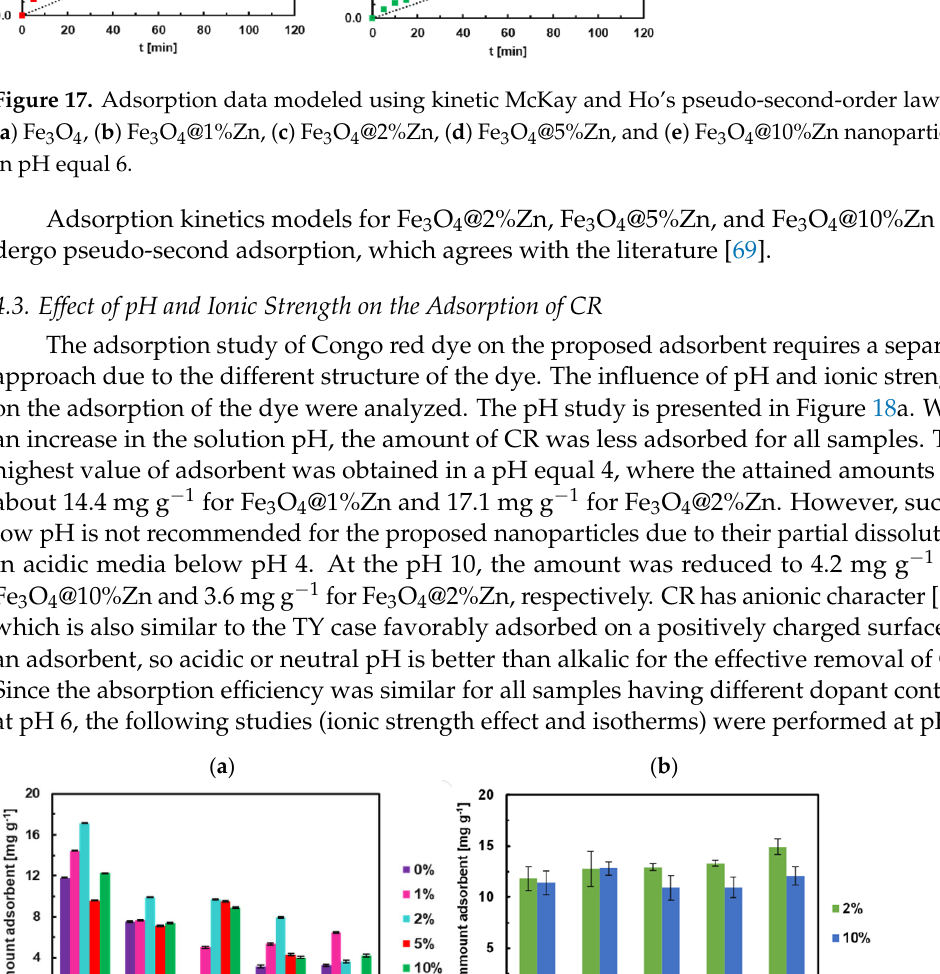
Figure 17. Adsorption data modeled using kinetic McKay and Ho’s pseudo-second-order law for ( a ) Fe 3 O 4 , ( b ) Fe 3 O 4 @1%Zn, ( c ) Fe 3 O 4 @2%Zn, ( d ) Fe 3 O 4 @5%Zn, and ( e ) Fe 3 O 4 @10%Zn nanoparticles in pH equal 6.